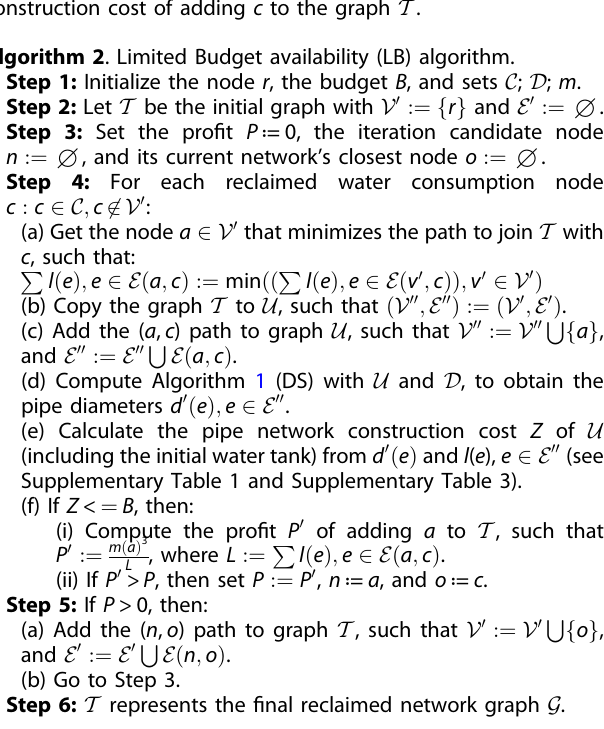
Algorithm 2 . Limited Budget availability (LB) algorithm. Step 1: Initialize the node r , the budget B , and sets C ; D ; m .